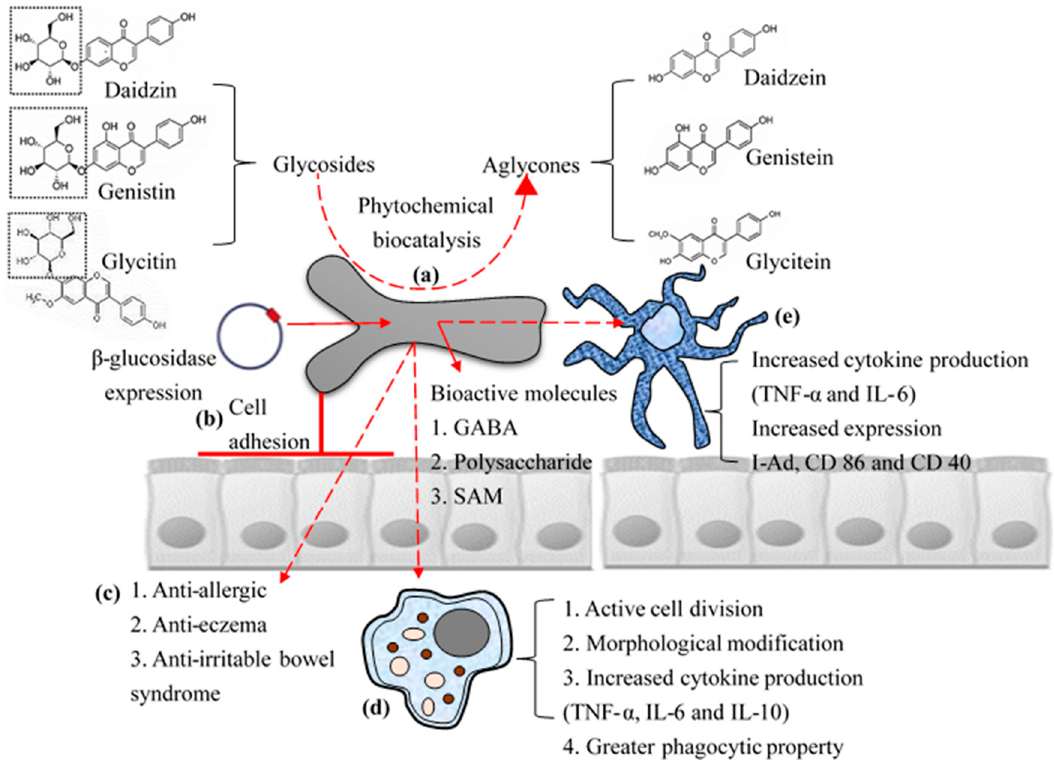
Figure 2. Schematic representation of biofunctional properties: Biotransformation of phytochemicals ( a ); high cell adhesion property with high surface hydrophobicity ( b ); and direct ( c ); and indirect immunomodulatory effects (activation of macrophages ( d ); and dendritic cells ( e )) of B. bifidum BGN4 to host.